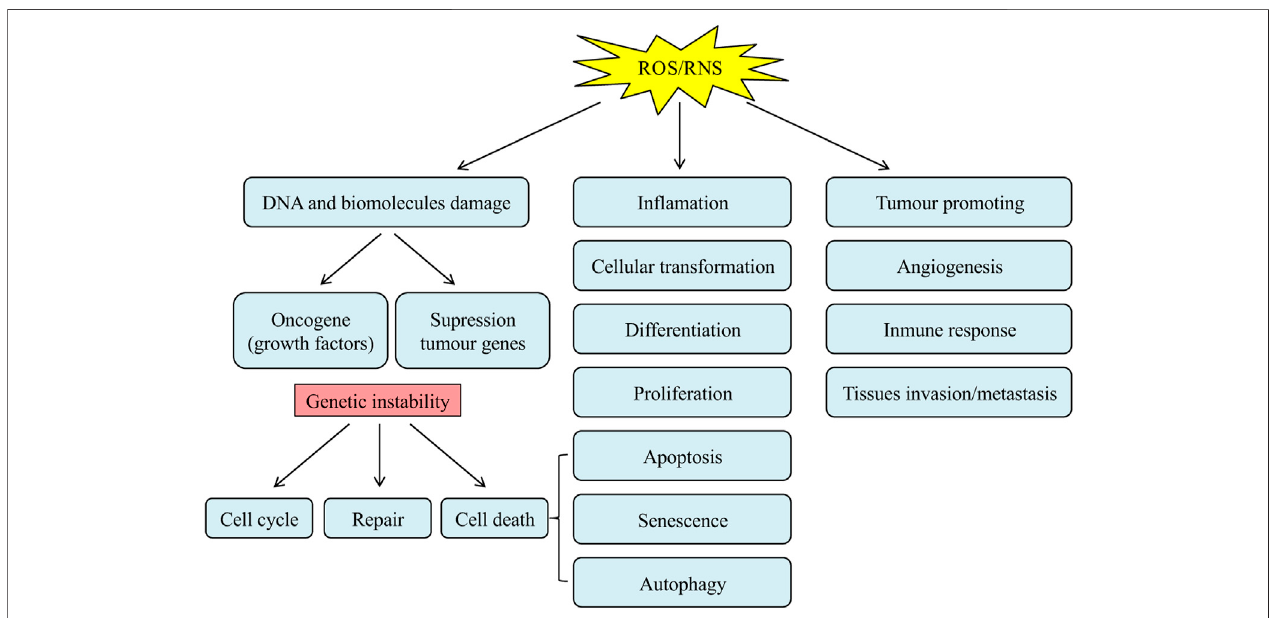
FIGURE 5 | The role of ROS/RNS in carcinogenesis (Ríos-Arrabal et al., 2013).